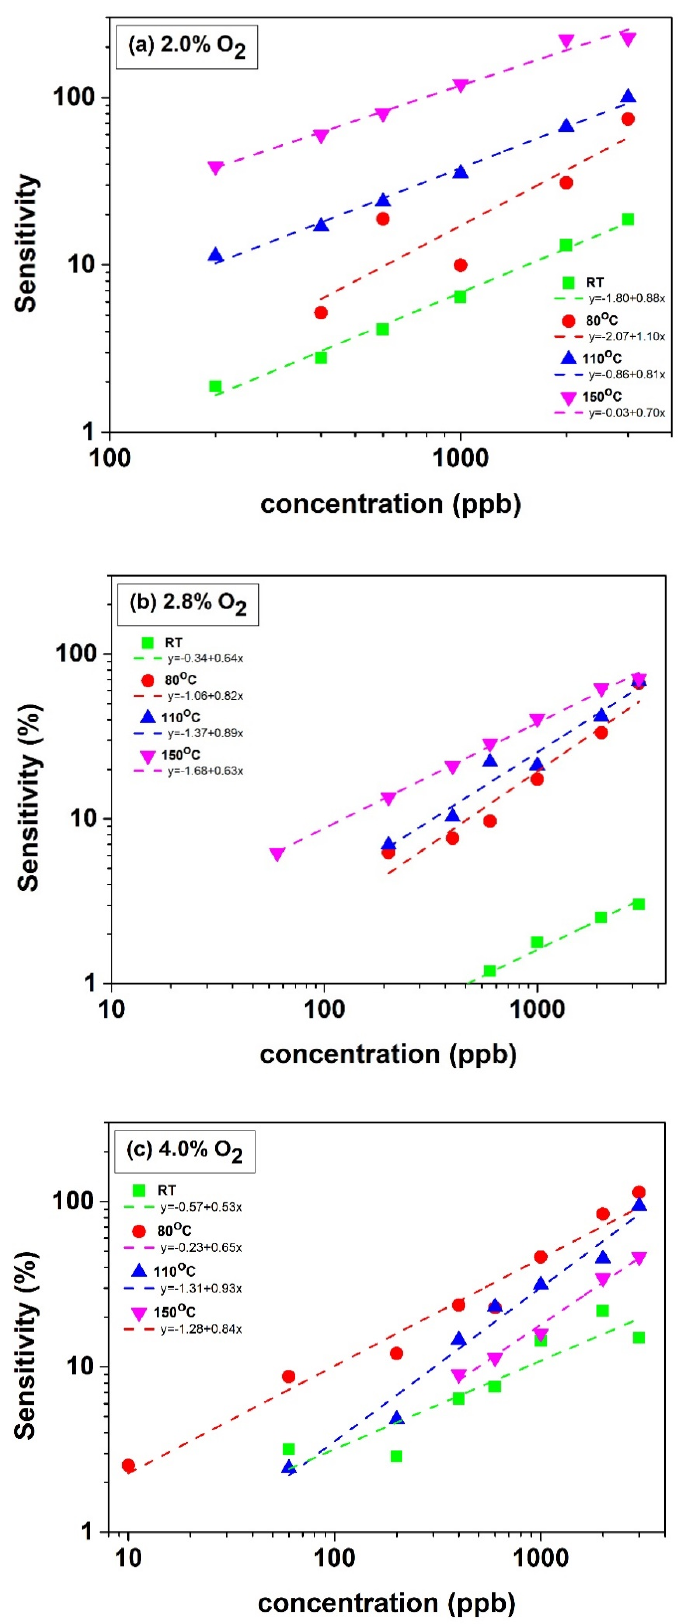
Figure 6. Sensitivity on different ozone concentrations at various operating temperatures of rf-sputtered NiO:Al with ( a ) 2.0%, ( b ) 2.8%, and ( c ) 4.0% O 2 in plasma. A linear fitting plot has been